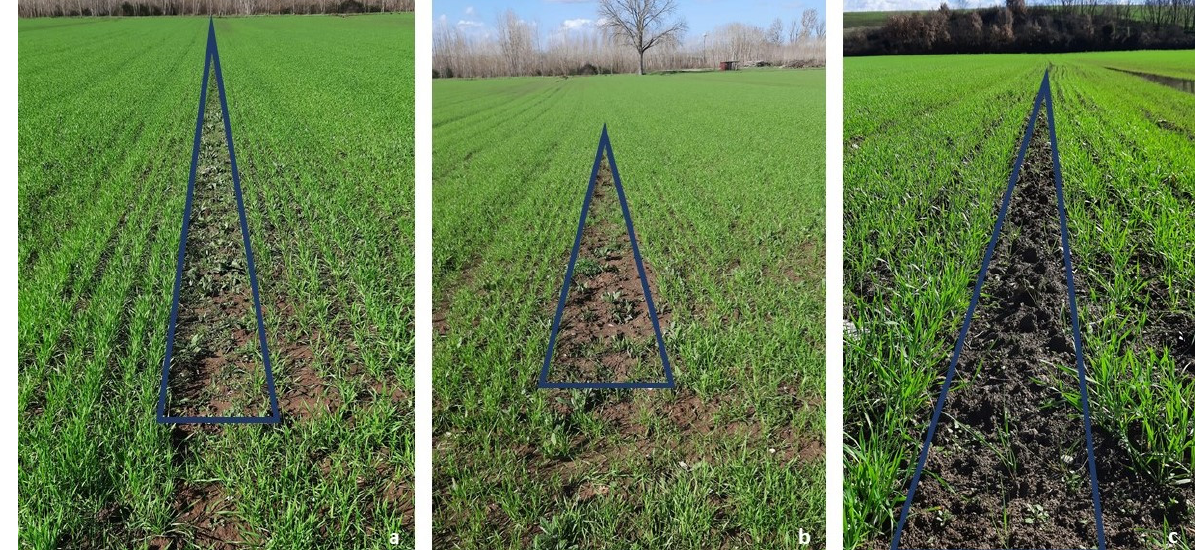
Figure 3. Unsown areas identified in the field, three different zones are reported as an example ( a ), ( b ) and ( c ).